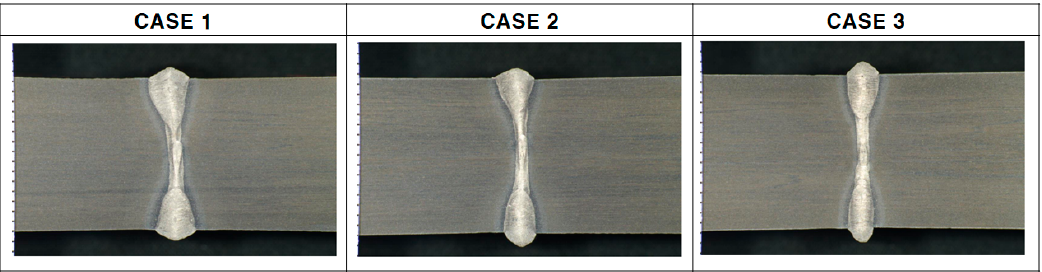
Figure 12. 15 mm thickness of high-manganese steel welding section observation result for each butt welding case.